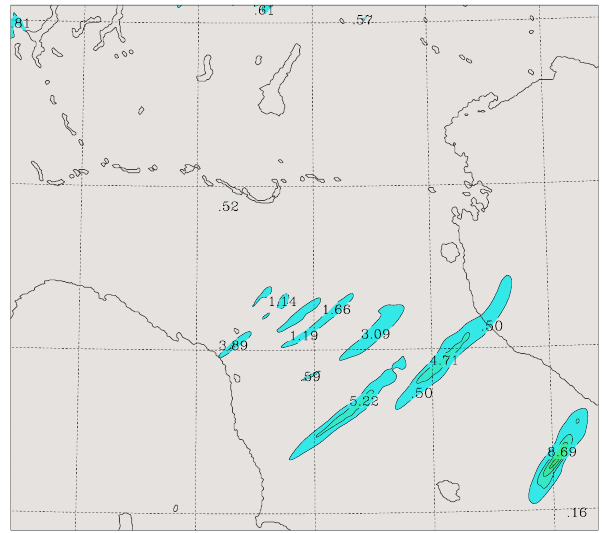
Fig. 7. Same as Fig. 6 except at 700 hPa. Contour interval 5ms − 1 .